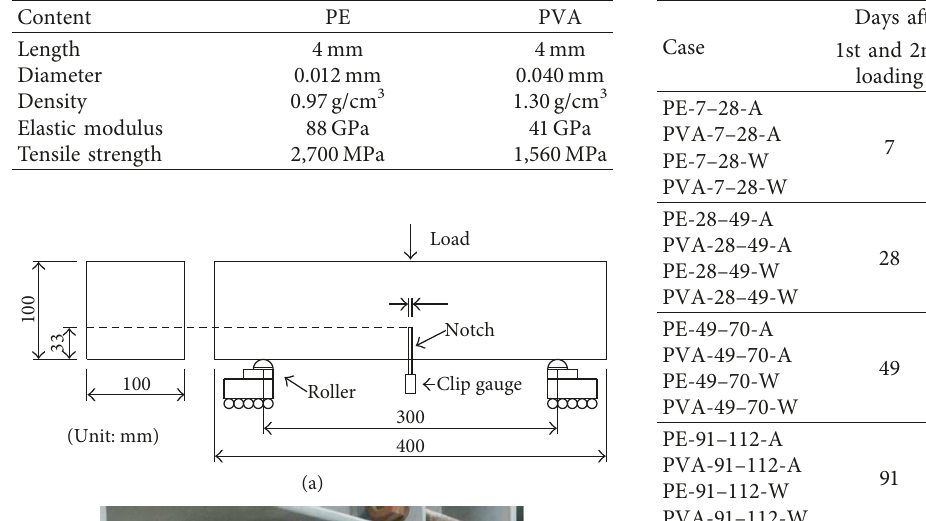
Table 4: Properties of fibers.